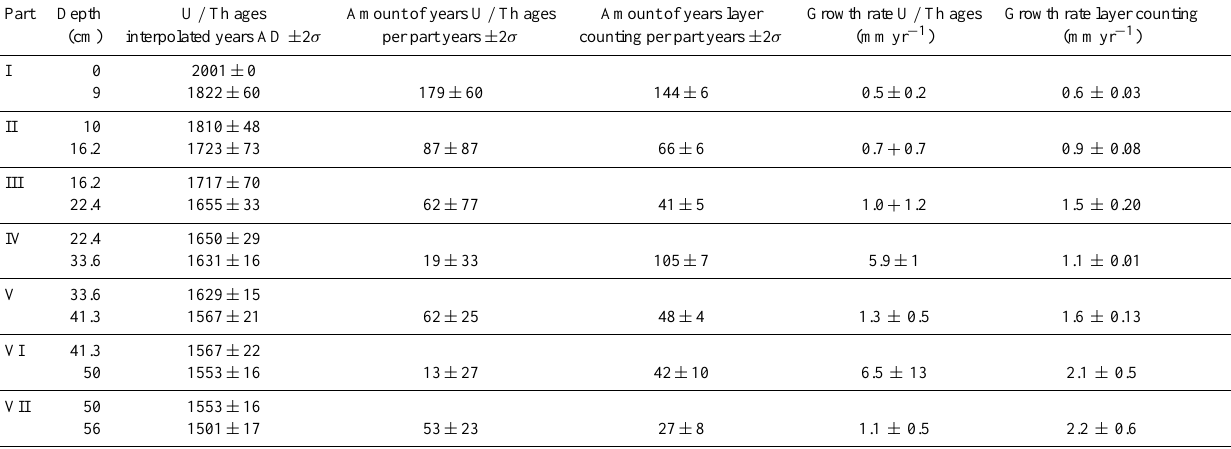
Figure 3. The δ 18 O and δ 13 C signals (‰ VPDB) and layer thickness of the Proserpine core plotted against distance from top. Blue bars indicate intervals during which the calcite aspect, δ 18 O and δ 13 C signals, and layer thickness all display simultaneous large-amplitude variations. Table 2. Comparison between the layer-counting ages and U / Th ages per part together with their growth rates. The interpolated U / Th ages for the top and the bottom of each part were obtained using StalAge. All values are reported with their 2 σ uncertainty range. Part Depth U / Th ages Amount of years U / Th